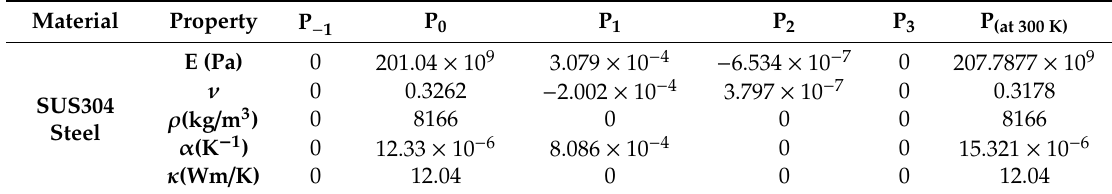
Table 4. Elasticity modulus ( E ), mass per density ( ρ ), coe ffi cient of thermal expansion ( α ) and